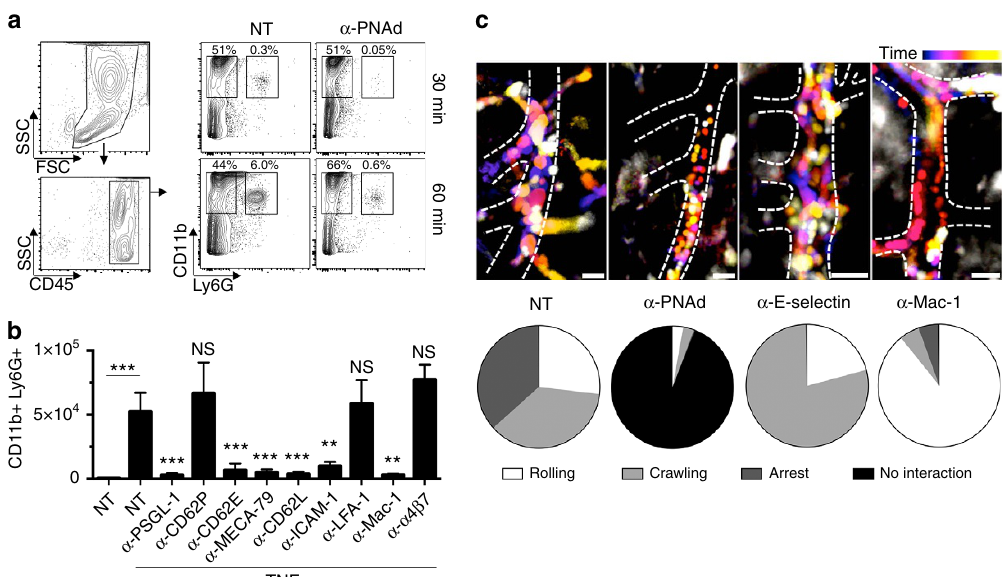
Figure 2 | Unique adhesion receptor requirements of HEV-mediated neutrophil recruitment. ( a ) Flow cytometry gating strategy and analysis of the peritoneal lavage after 30 or 60min of TNF a -induced peritonitis with and without (NT, non-treated) PNAd inhibition by high-dose i.v. MECA-79 mAb injection. Data representative of two independent experiments. ( b ) The effect of different blocking antibodies on neutrophil accumulation in the abdominal lavage was evaluated after 1h TNF a treatmensing flow cytometry as in (a). n ¼ 6 of least three independent experiments. Data as mean total cell number ± s.d. Statistical significance is indicated relative to NTwith TNF a . Student’s t -test ** P o 0.01, *** P o 0.001. ( c ) To investigate the luminal neutrophil behaviour, E-selectin, L-selectin or Mac-1 was blocked by i.v. injection of monoclonal antibodies and intravital microscopy of inflamed omental milky spots was performed in LysM-eGFP mice at high magnification. Time is colour-coded and visualizes cell motion within 3–5min duration. Dashed lines indicate vessel borders. Scale bar, 20 m m. Quantification of intraluminal neutrophil behaviour in HEVs shown as pie charts for each condition. Cell numbers for rolling/crawling/arrest/time without any neutrophil–endothelium interaction in seconds: NT n ¼ 25/33/34/0, a -PNAd ¼ 1/1/0/210, a -E-selectin n ¼ 9/34/0/0 and a -Mac-1 n ¼